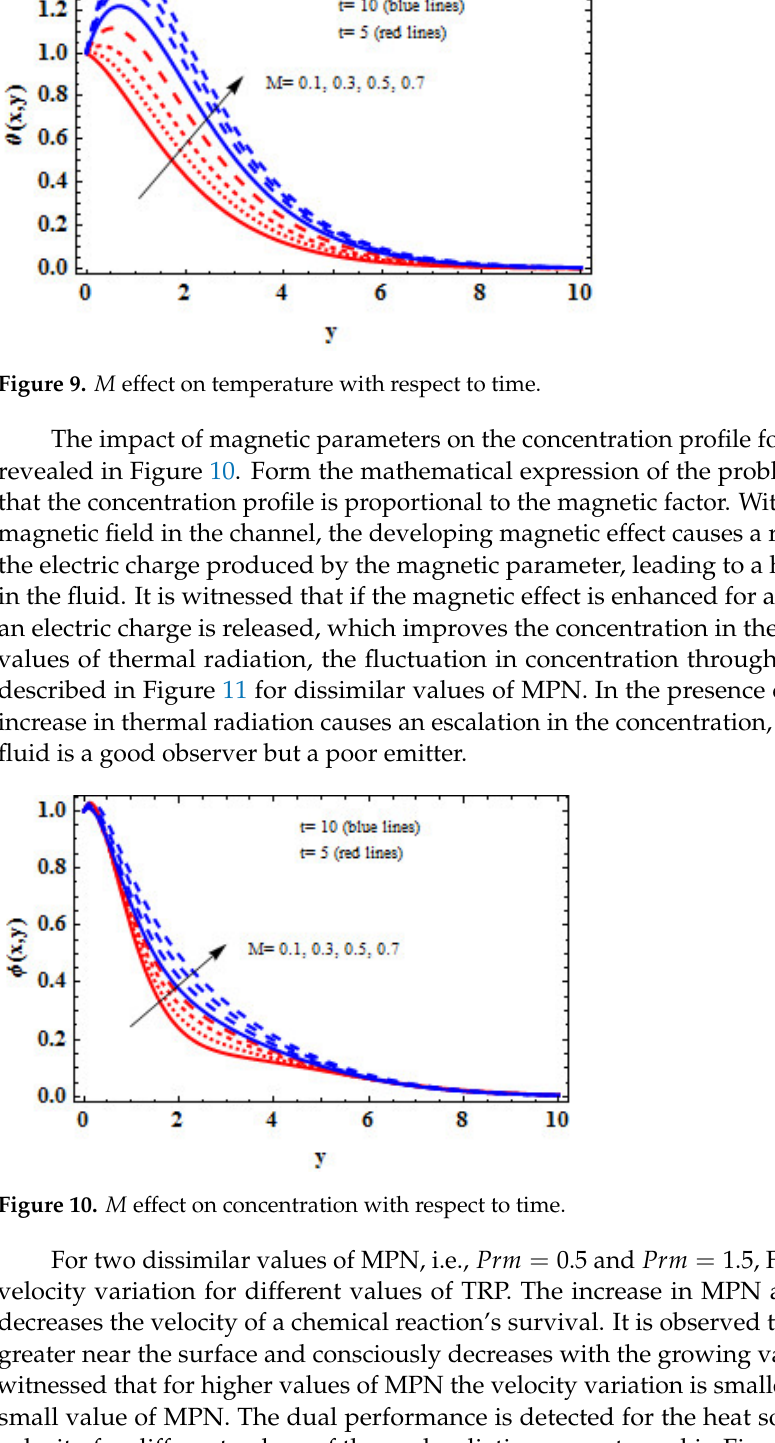
Figure 11. effect on concentration with respect to .